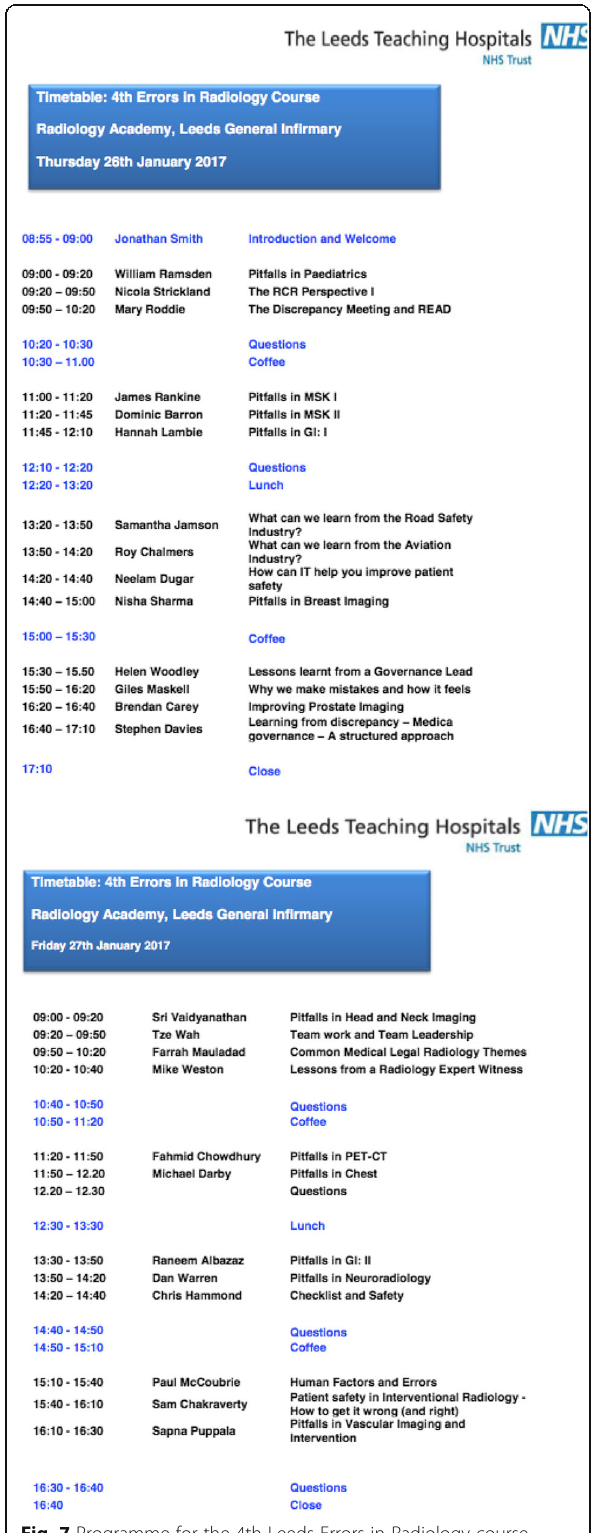
Fig. 7 Programme for the 4th Leeds Errors in Radiology